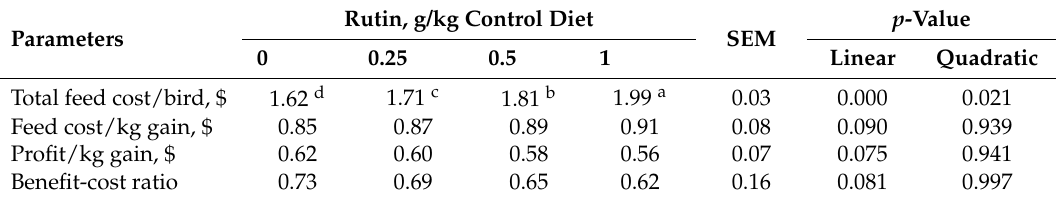
Table 6. Effect of dietary rutin on the economic efficiency of broilers (at 42 days of age). Parameters Rutin, g/kg Control